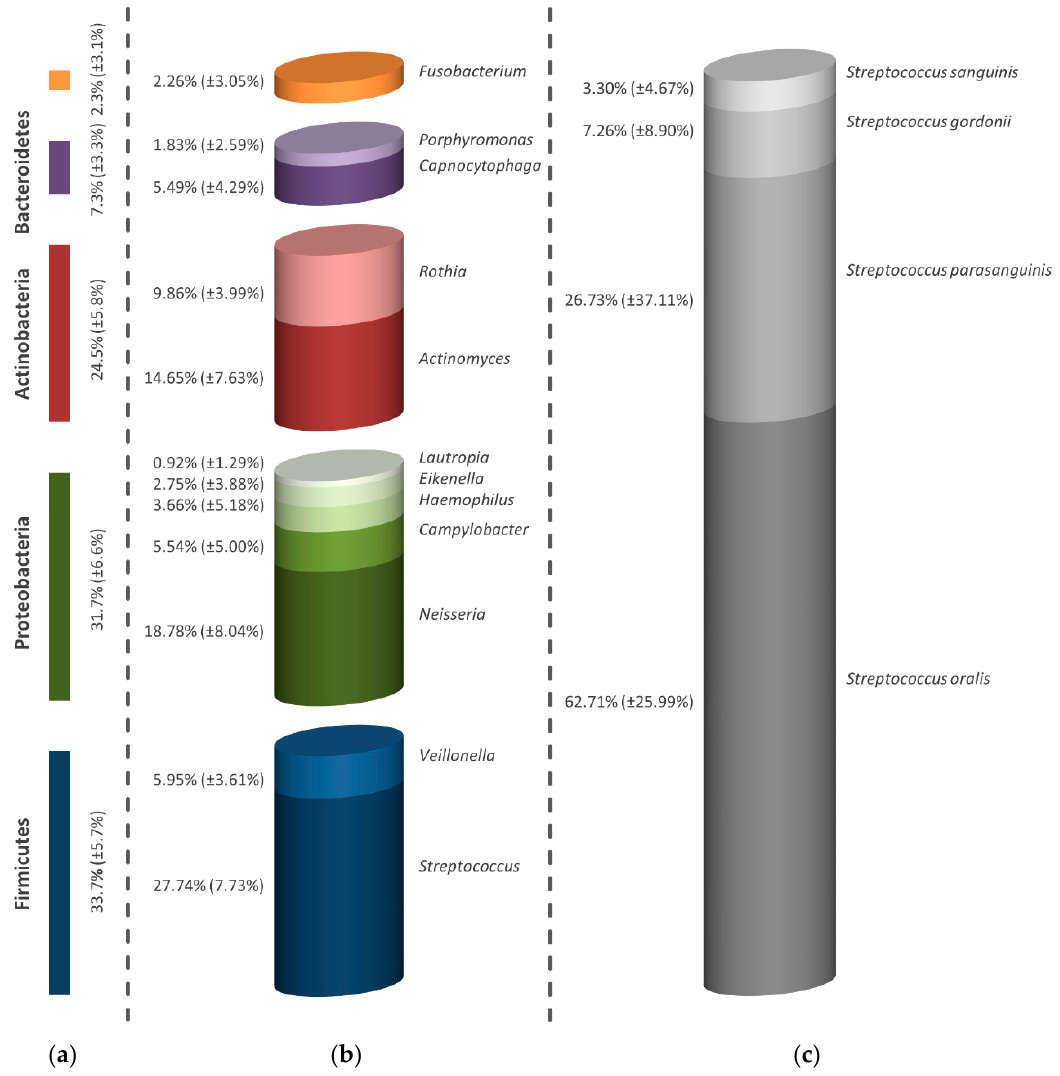
Figure 7. Visualization of surviving microorganisms within the mature biofilm treated with 450 µg/mL ICG after aPDT. The percentages of the bacteria in the total microbial composition of all examined subjects are given. The graph shows a division into strain ( a ), genus ( b ) and dominant bacterial species ( c ). The bars depict the average values in percentage of six discs (two from each volunteer). In addition to the average values, the standard deviations are also presented in parentheses.